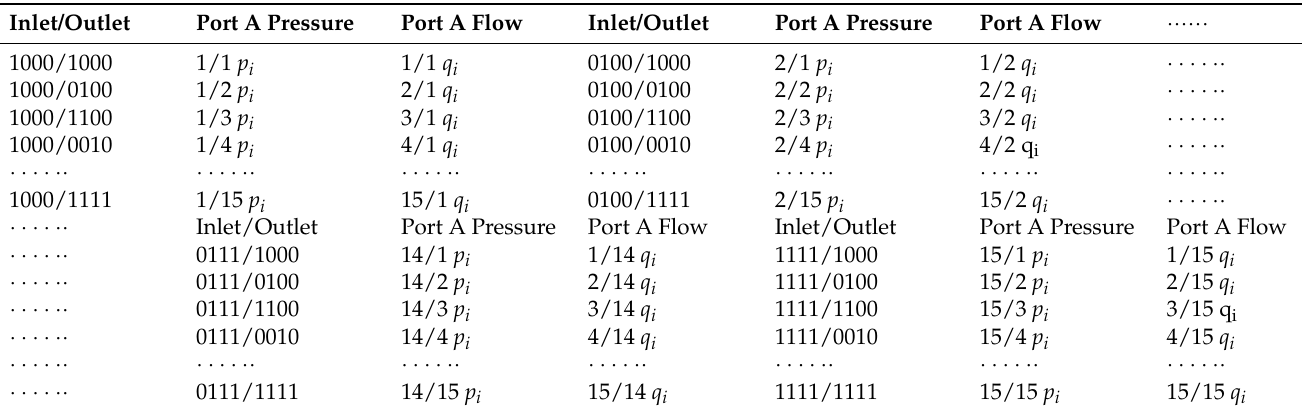
Table 1. Combination table of DHT control valve group